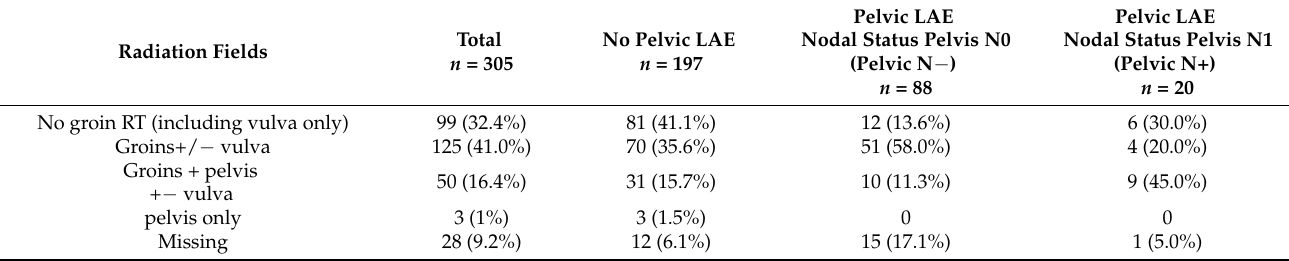
n = 305, 1 patient with unknown pelvic status